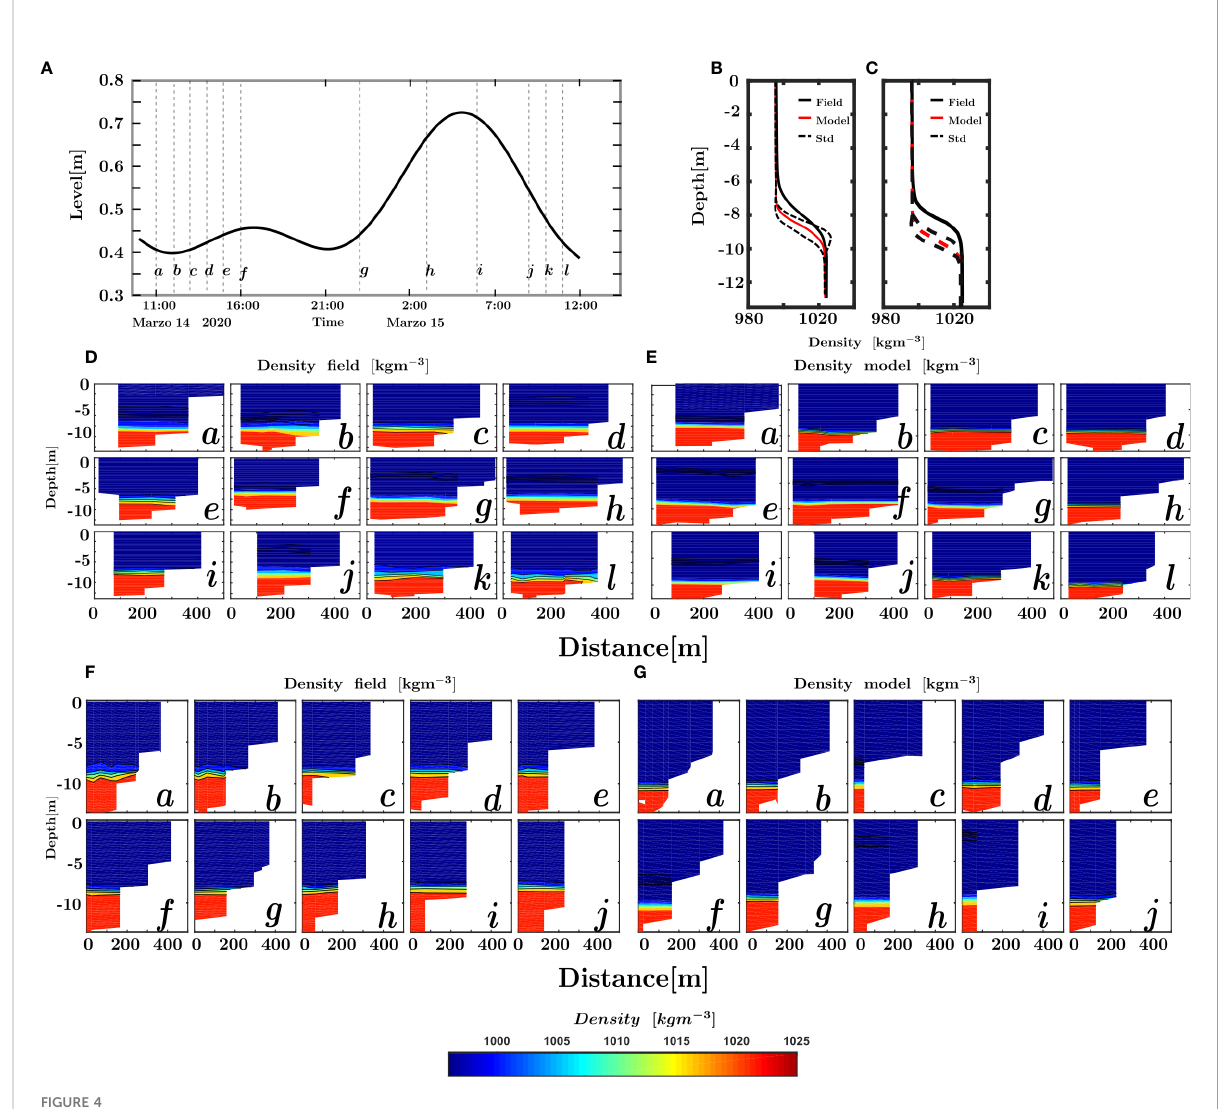
FIGURE 4 Cross-sectional distribution of measured and modeled density in the inner MRE in section S1 and S2 for the 2020 dry season. (A) Water level.Measured and modeled average density pro fi le S1 (B) and S2 (C) . Measured (D, F) and modeled (E, G) density in the cross sections at different tidal stages [according to panel (A) ] in sections S1 (D, E) and S2 (F, G) . The letters a-l is diferents moments of